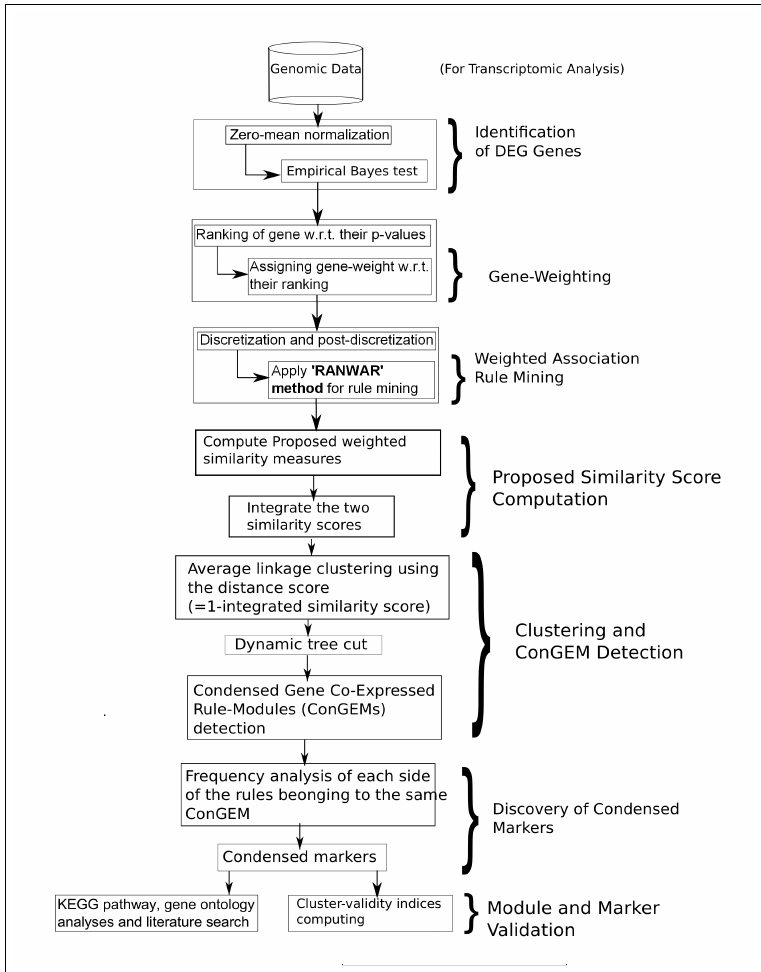
Figure 2. Flowchart of the proposed method, whereas “w.r.t.” denotes “with respect